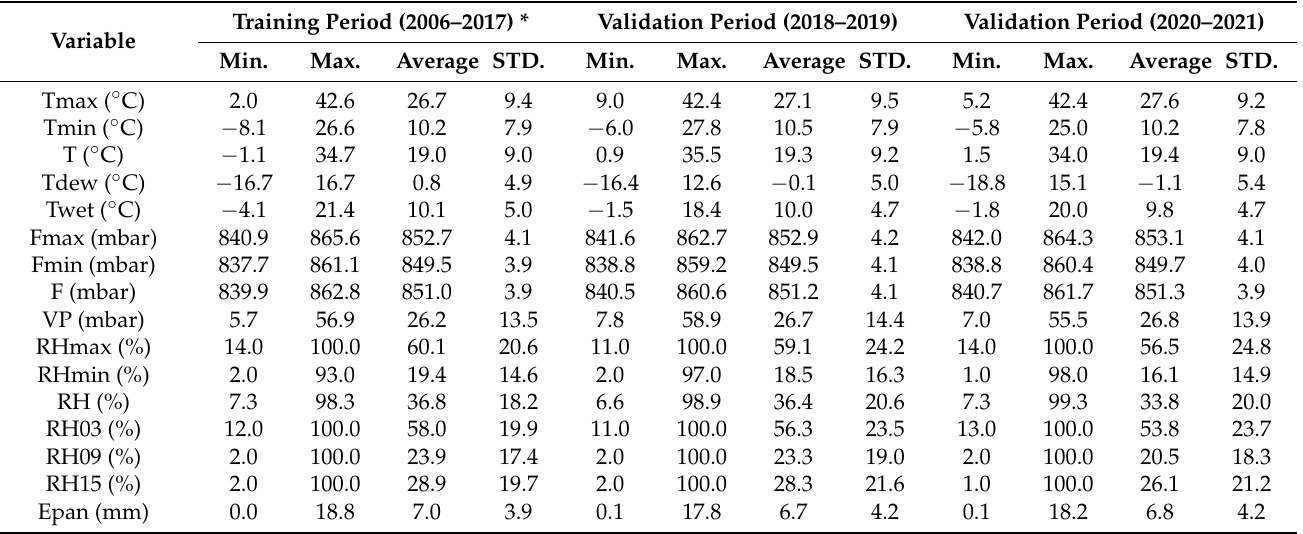
Table 1. Details of the daily datasets of the Shiraz site are obtained from the Iranian Meteorological